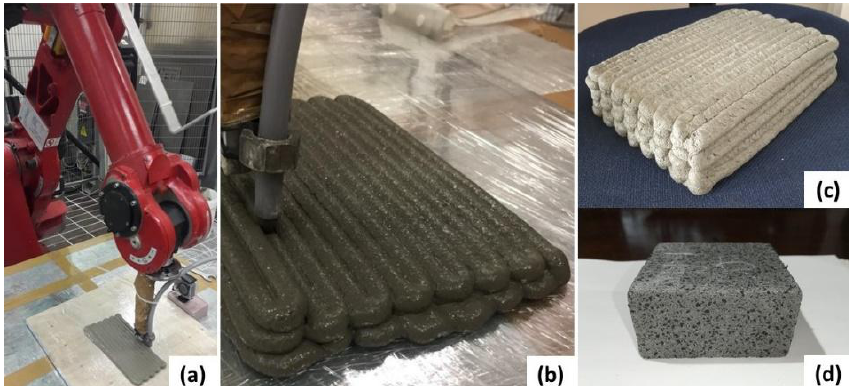
Figure 8. Phases of the 3D-printing manufacturing process: ( a ) robotic arm operation, ( b ) layer-by-layer deposition of the cementitious mix, ( c ) hard-state printed slab, and ( d ) internal structure of the p-RuC sample.